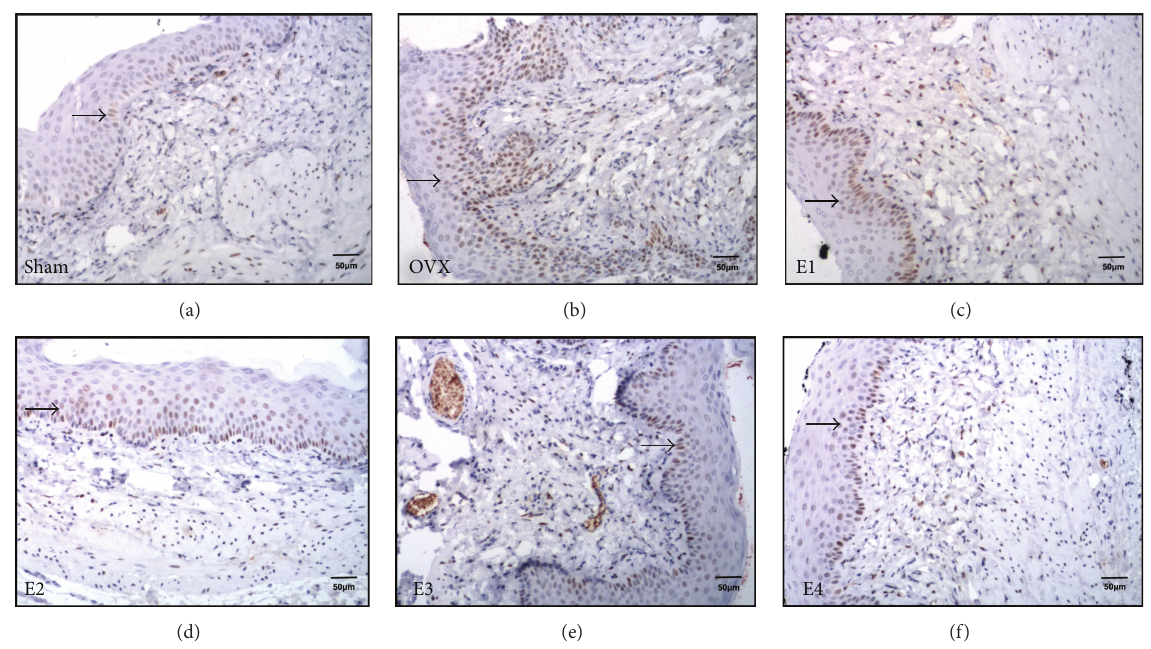
Figure 2: ER 𝛼 immunostaining of vaginal tissue sections. (a)–(f) show ER 𝛼 immunostaining of vaginal tissue sections from sham, OVX, E1, E2, E3, and E4 groups, respectively. ER 𝛼 -immunoreactive cells are indicated by small black arrows. The staining is primarily nuclear in the vaginal stratified squamous epithelium (basal, para-basal, and intermediate cell layers) and in the stromal fibroblasts or nonvascular smooth muscle cells in the lamina propria. Scale bar represents 50 𝜇 m (200x magnification). ER 𝛼 , estrogen receptor- 𝛼